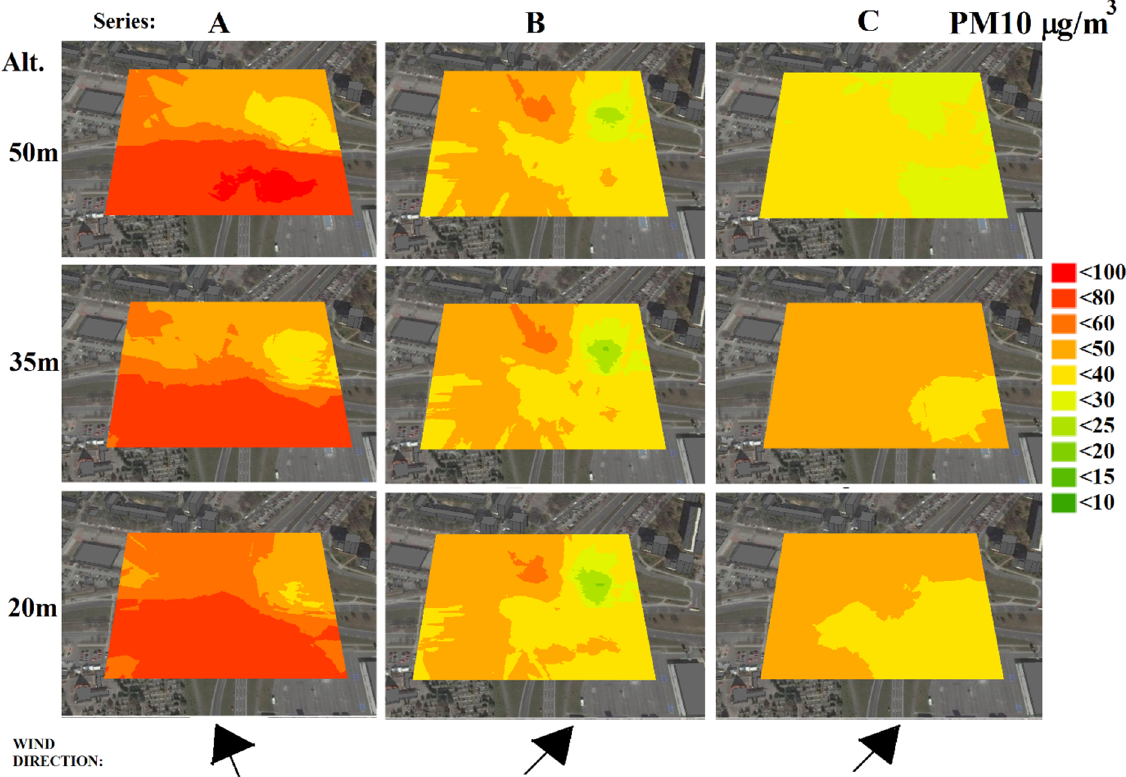
Figure 9. Spatial distribution of PM 10 pollution at the altitude of 20, 35 and 50 m for three measurement series in the area of the street intersection. Table 4. Measurement data from the intersection area for three selected measurement series.